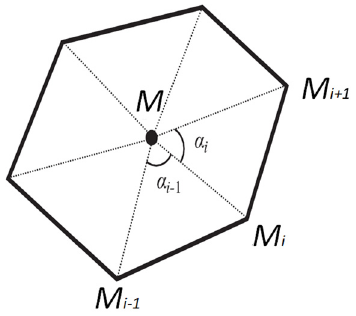
Figure 4. Illustration of mean-value coordinates.